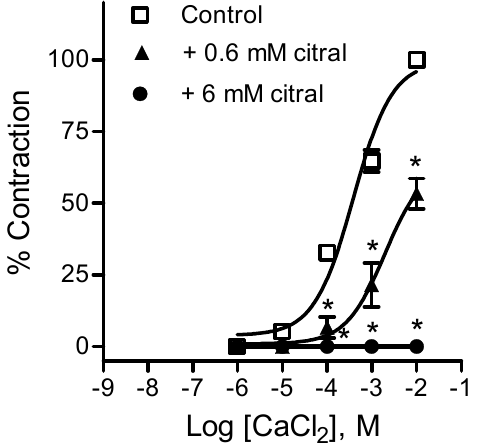
Figure 5. Effects of citral on Ca 2+ -induced contraction of depolarized endothelium- denuded aorta from WKY rats. Contractions were taken as 100% in the presence of 10 − 2 M CaCl (control curve). Data are mean ± SEM (n = 4). * p < 0.01 vs. 2